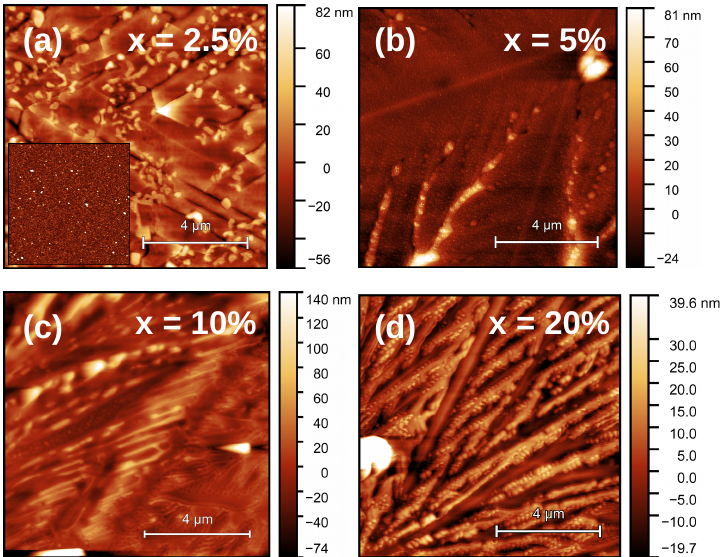
Figure 1. AFM pictures of the films after annealing. The RMS roughnesses are 18 nm ( a ), 8 nm ( b ), 12 nm ( c ), and 31 nm ( d ). Note that, while the image size is identical for all of them, the Z scale is not. Inset: image of the pristine 2.5% sample (RMS roughness = 3 nm).